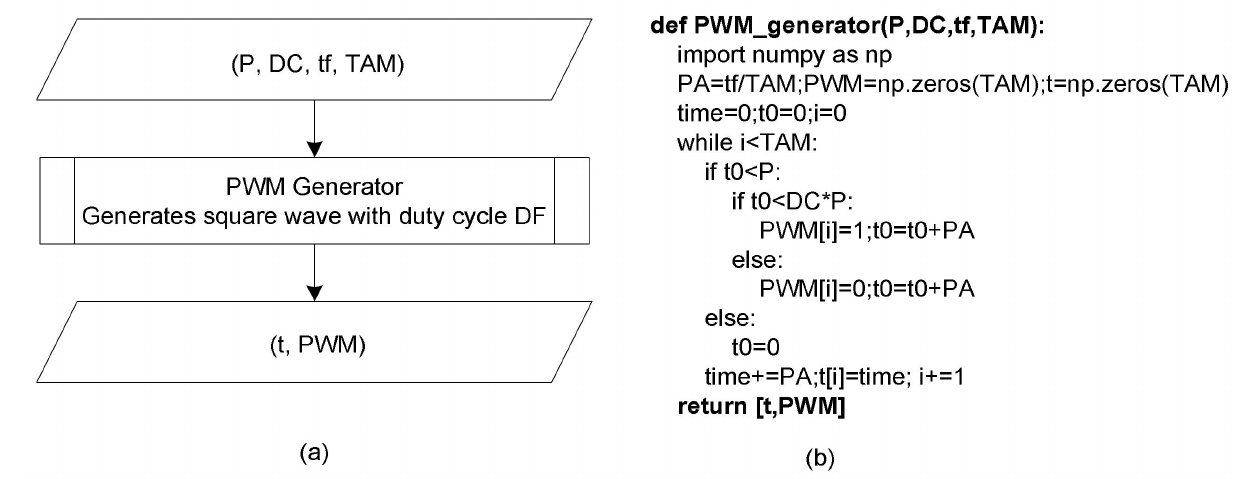
Figure 6. Function that generates the output PWM signal: ( a ) Algorithm and ( b ) Python code. Figure 7 shows the main function flowchart.